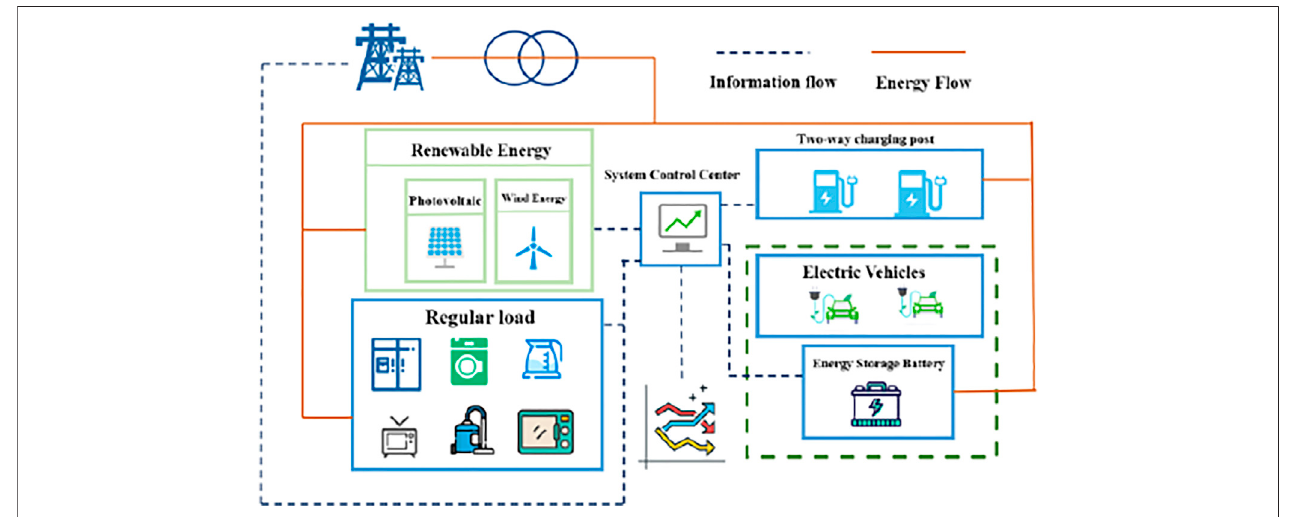
FIGURE 1 | Framework for distributed energy